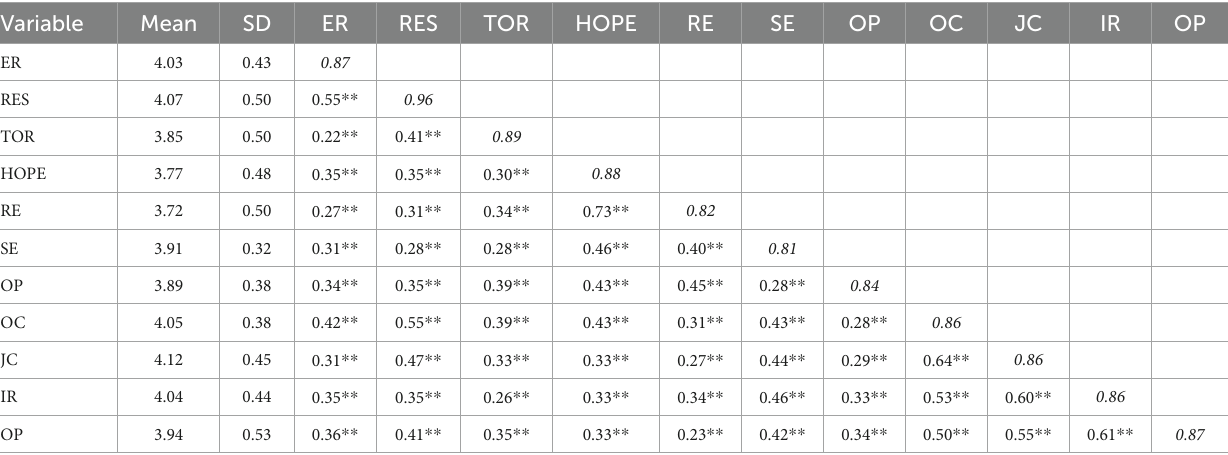
TABLE 6 Descriptive statistics and correlation matrix.